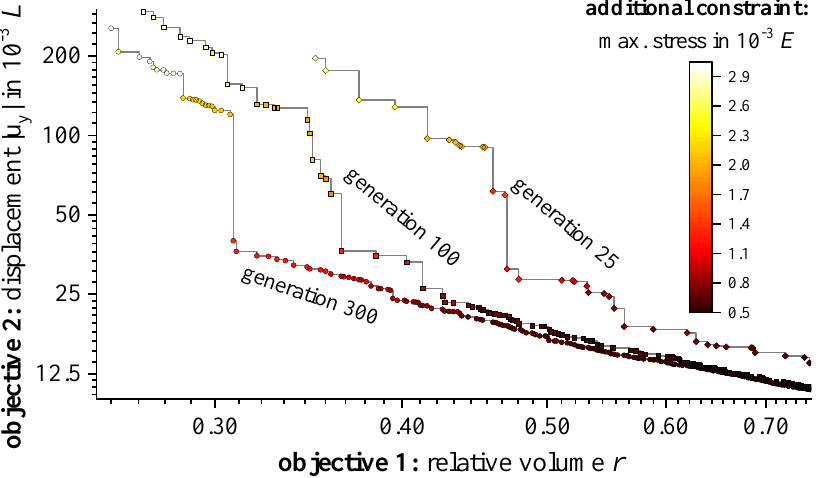
Figure 10. Sets of obtained solutions in objective space after 25, 100 and 300 generations with a population size of 300. The additional constraint of maximum tolerated von Mises stress of 0.003 E is indicated by